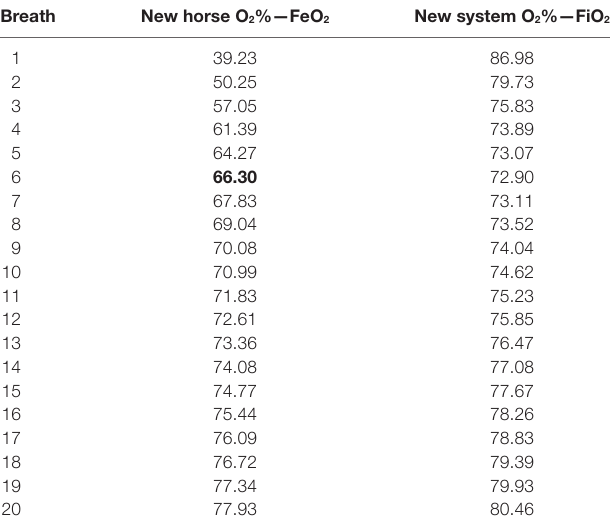
Table 1 | Modeling of